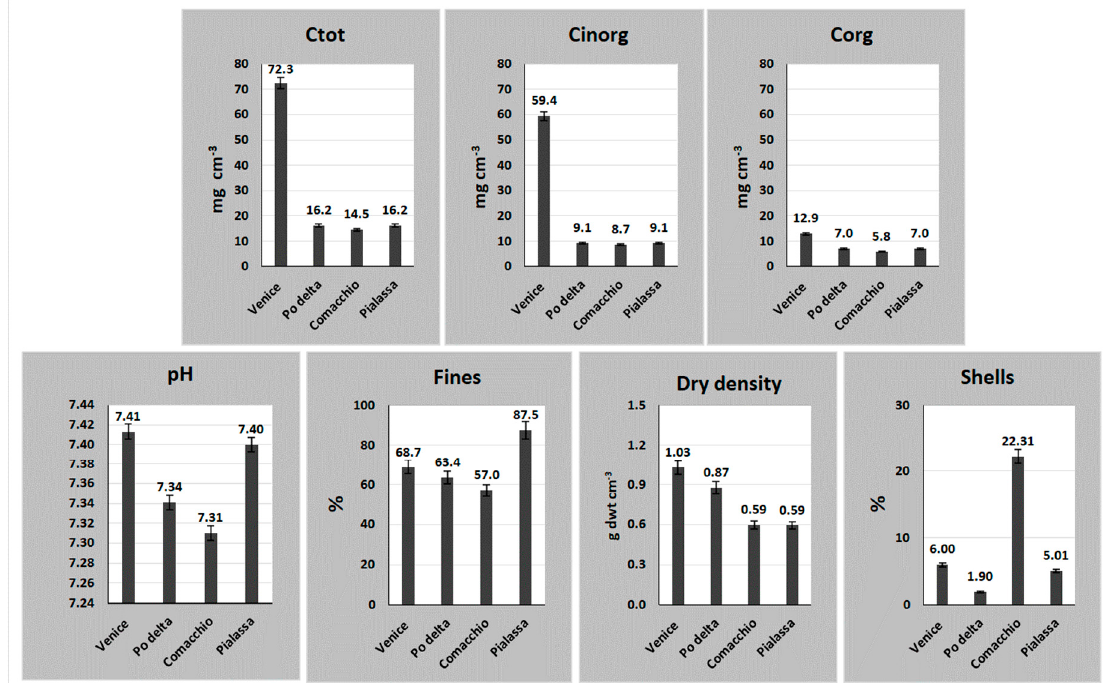
Figure 2. Average values of the carbon species (Ctot, Cinorg, Corg) and sediment parameters (pH, fines, dry density, shell fragments) in the studied TWSs.